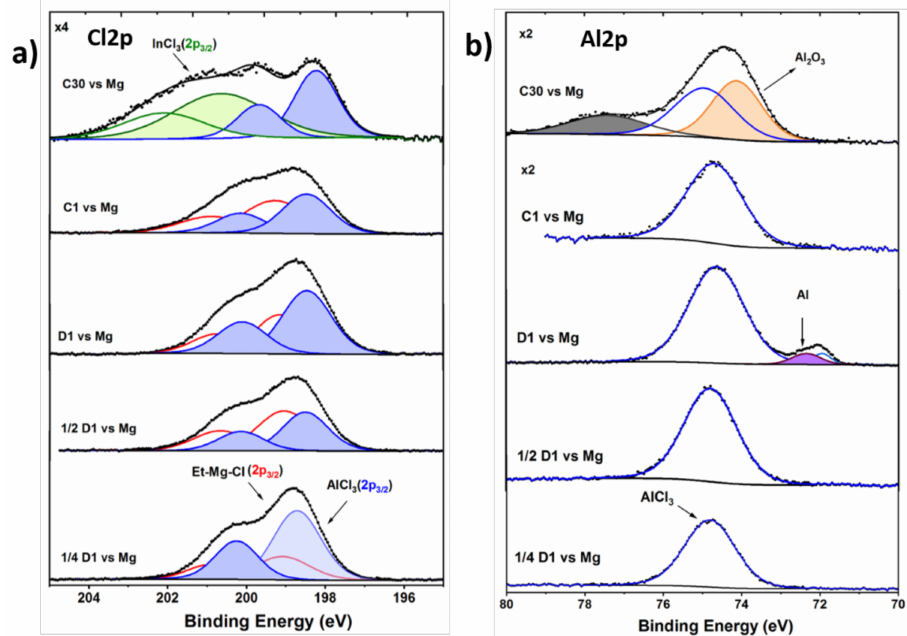
Figure 5. ( a ) Cl2p and ( b ) Al2p core peaks spectra of the InSb electrodes cycled in EtMgCl–Et 2 AlCl/THF electrolyte vs.